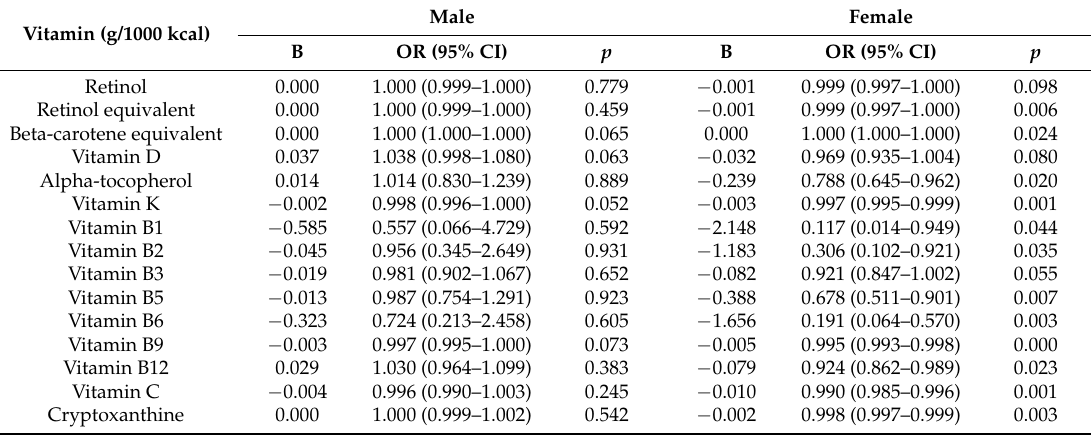
Table 5. Odds ratios (95% CI) for depressive symptom outcomes according to vitamin intake stratified by gender